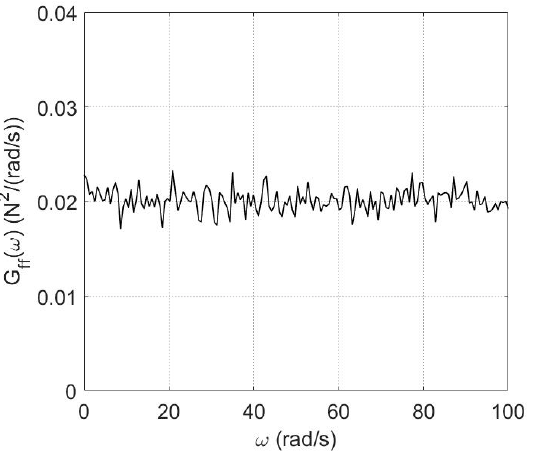
Figure 1. Six-DOF chain model of a cantilever beam.